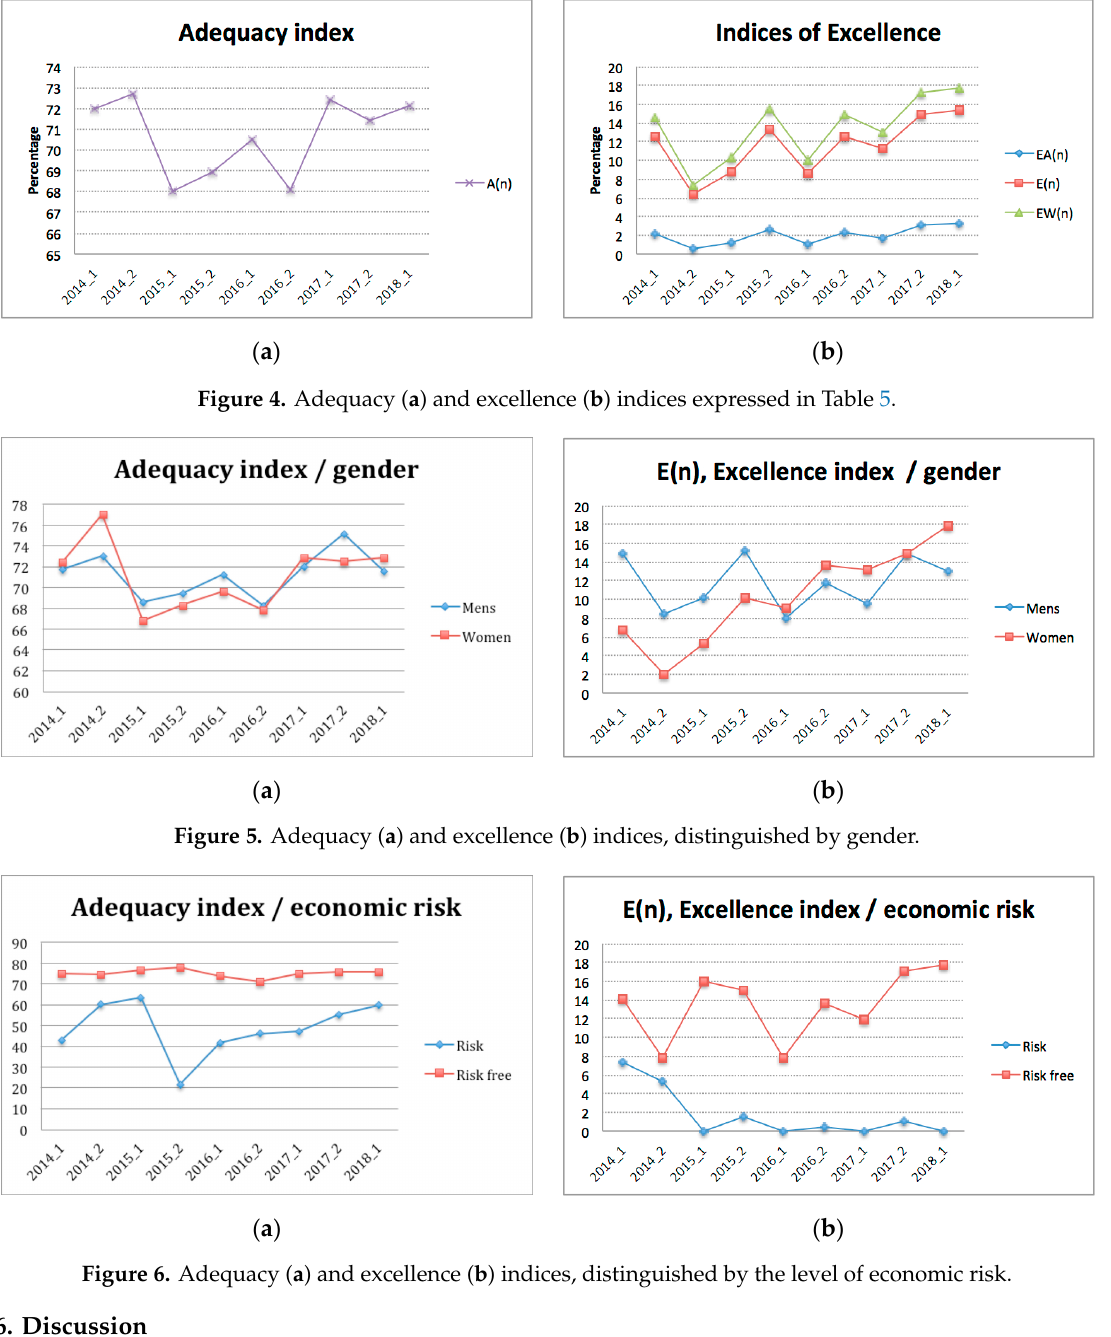
Figure 4. Adequacy ( a ) and excellence ( b ) indices expressed in Table 5.